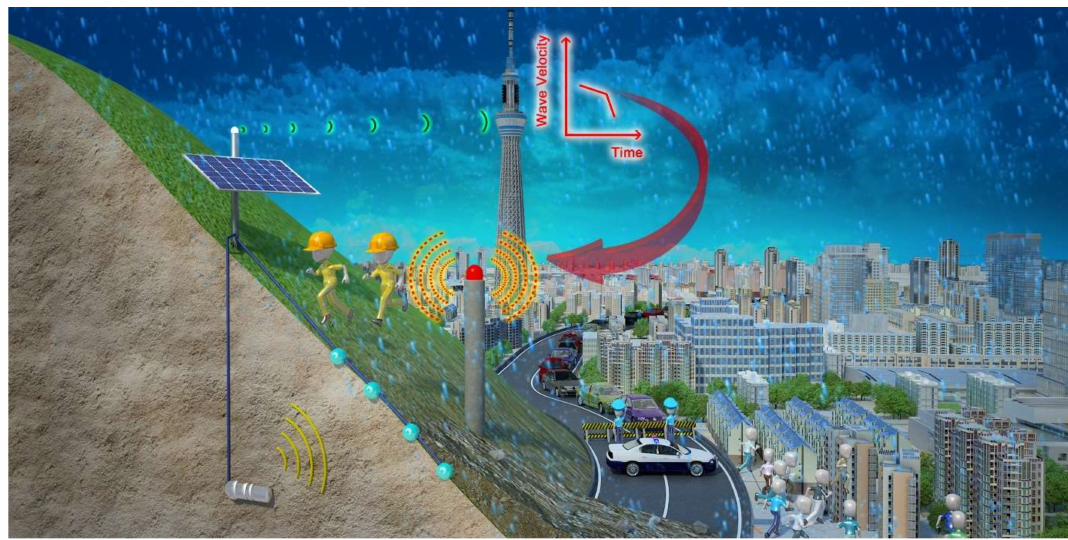
Figure 15. The operation of the elastic wave velocity monitoring